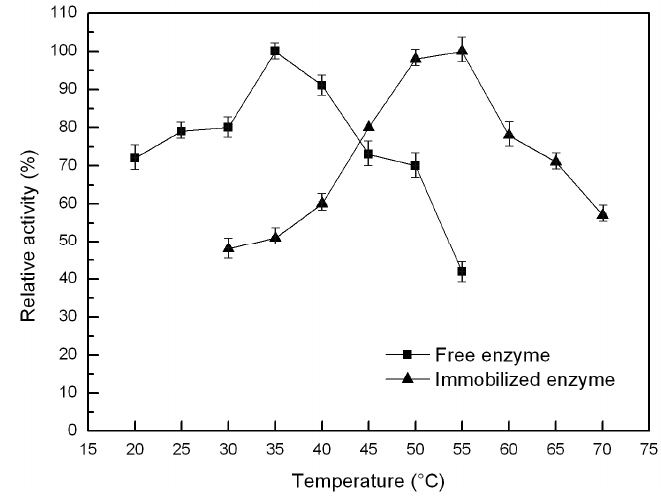
Figure 5. The effect of temperature on the free and immobilized enzyme.